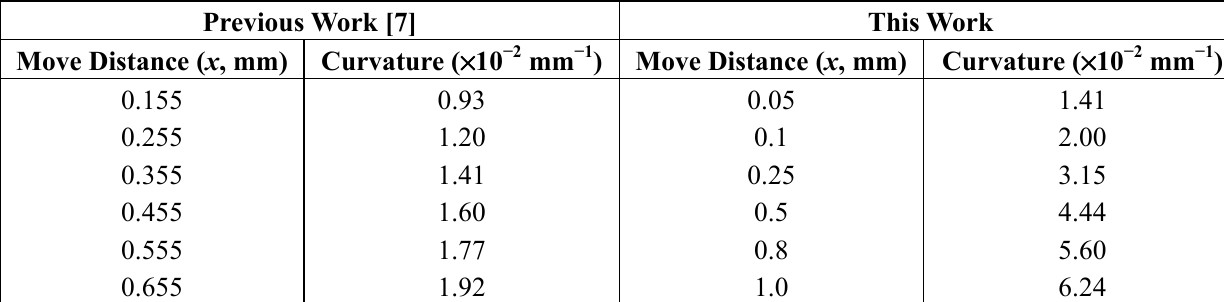
Table 2. Data points for previous work [7] and this work.